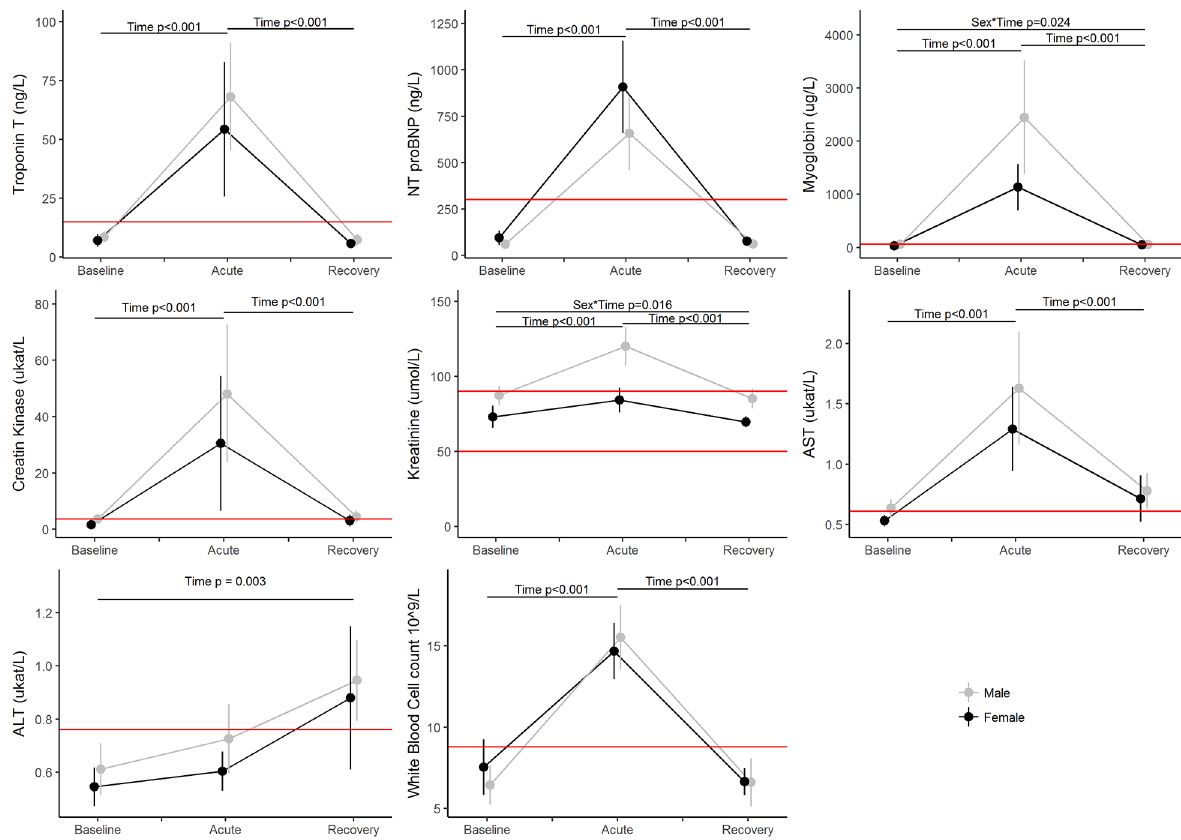
Fig 1. Mean and 95% confidence intervals of the biomarkers by sex from baseline (T1) to recovery(T3). The horizontallines indicateclinical reference values. The p-valuesare from the linear mixed models.